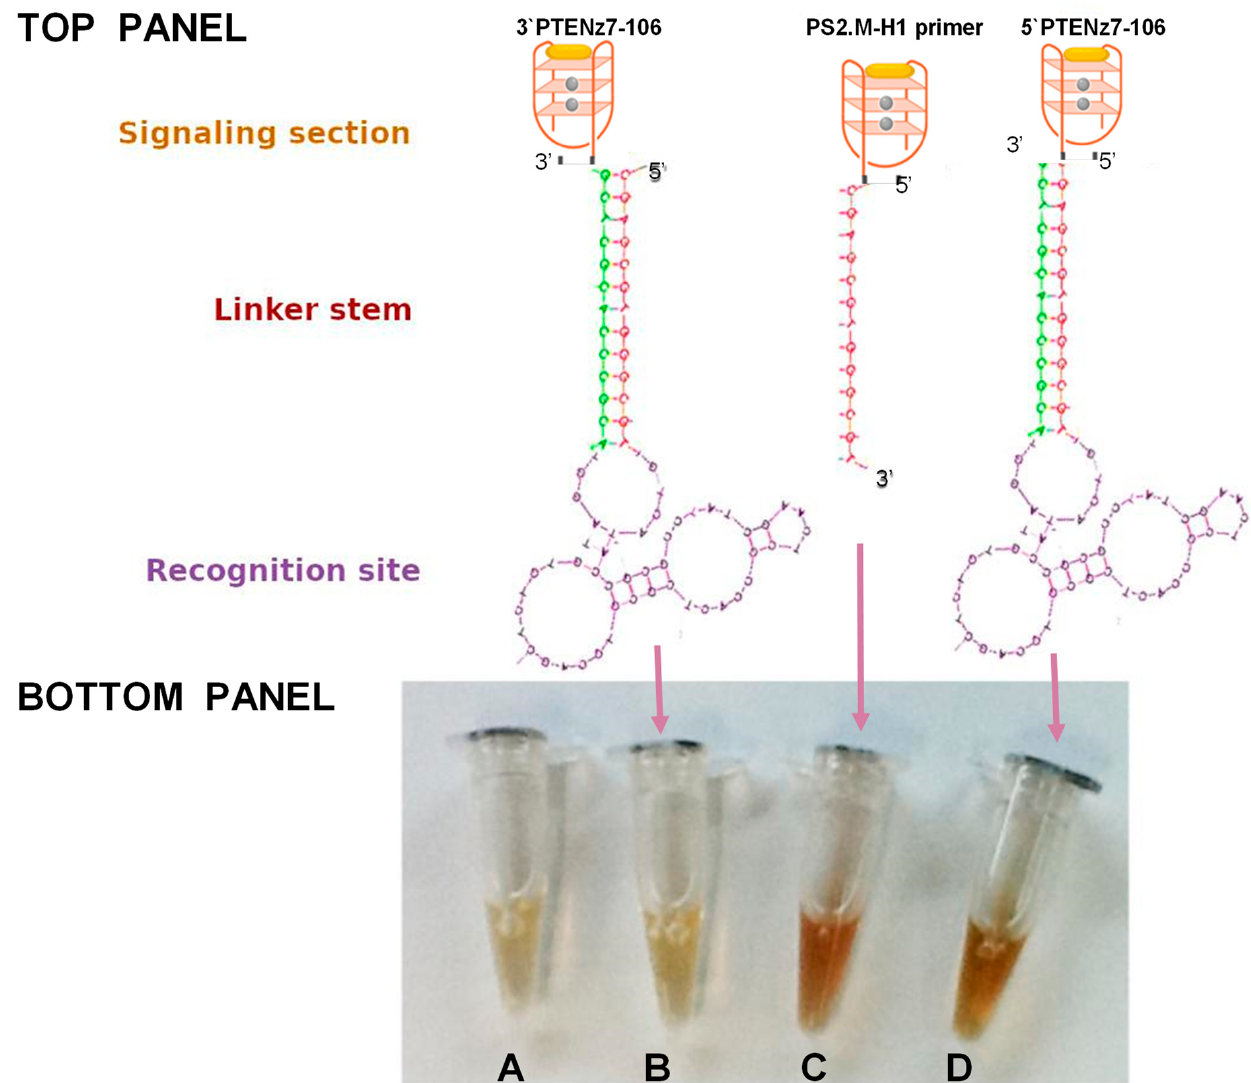
Figure 1. Top Panel: Schematic representation of a DNAzyme peroxidase-aptamer conjugates 3 (cid:48) PTENz7-106, PS2.M-H1, and 5 (cid:48) PTENz7-106. Gray circles represent potassium, and yellow oval hemin. Bottom Panel: Oligonucleotide peroxidase activity developed with 3,3’-diaminobenzidine (DAB) after 5 min in reaction containing the DNAzyme peroxidase-aptamer conjugates indicated by arrows ( B – D ). ( A ) = no DNAzyme (Control). The sequences of these DNAzyme/aptamers are shown in Table 1 using the same color